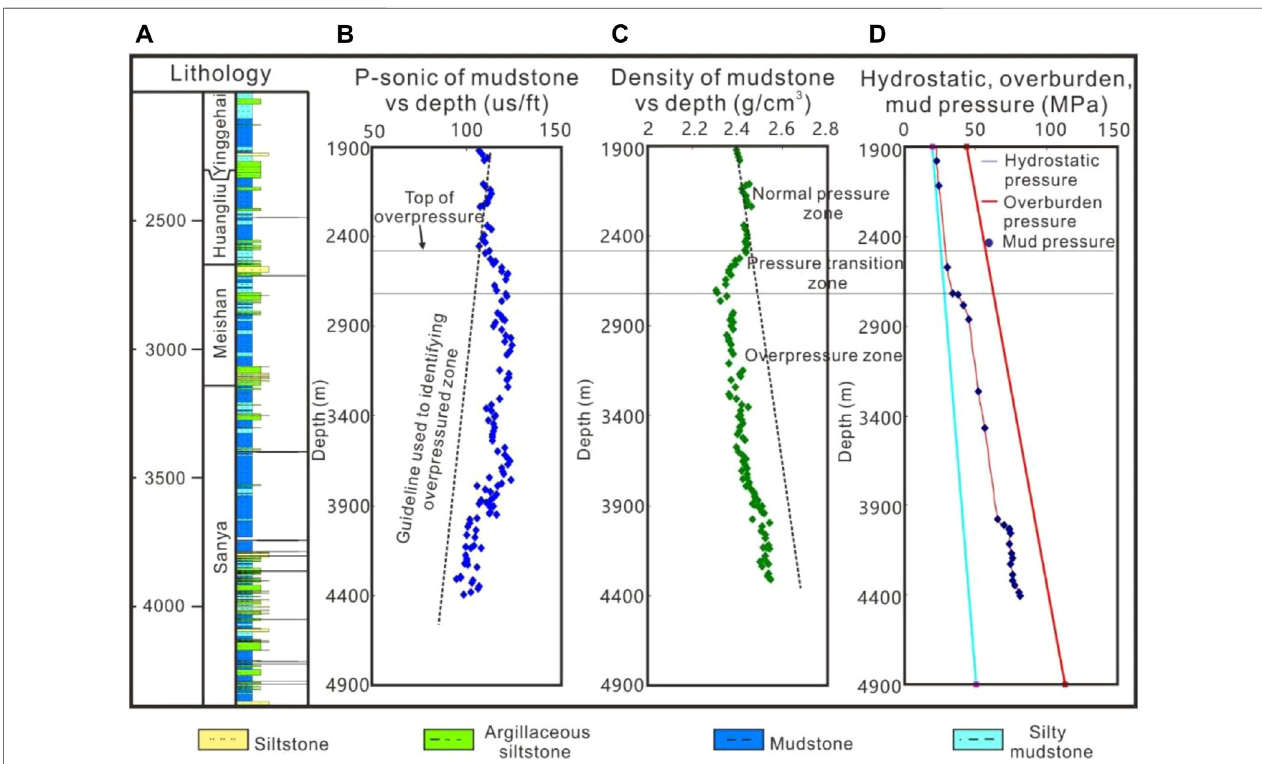
FIGURE 12 | (A) Lithologic pro fi le of Well C (B) Pseudo log of sonic P-wave transit times for mudstone. The plot shows the deviation of transit time from the compactiontrendbelowabout2,450 m. (C) Plotoflog-deriveddensityvaluesformudstoneshowingdeviationfromthecompactiontrendbelowabout2,450 m. (D) Plot of calculated mud pressures showing a corresponding positive deviation from hydrostatic pressure (overpressure) below about 2,450 m. The decreasing density in the overpressured section of well C indicates that disequilibrium compaction is a primary cause of overpressure in the Qiongdongnan Basin.